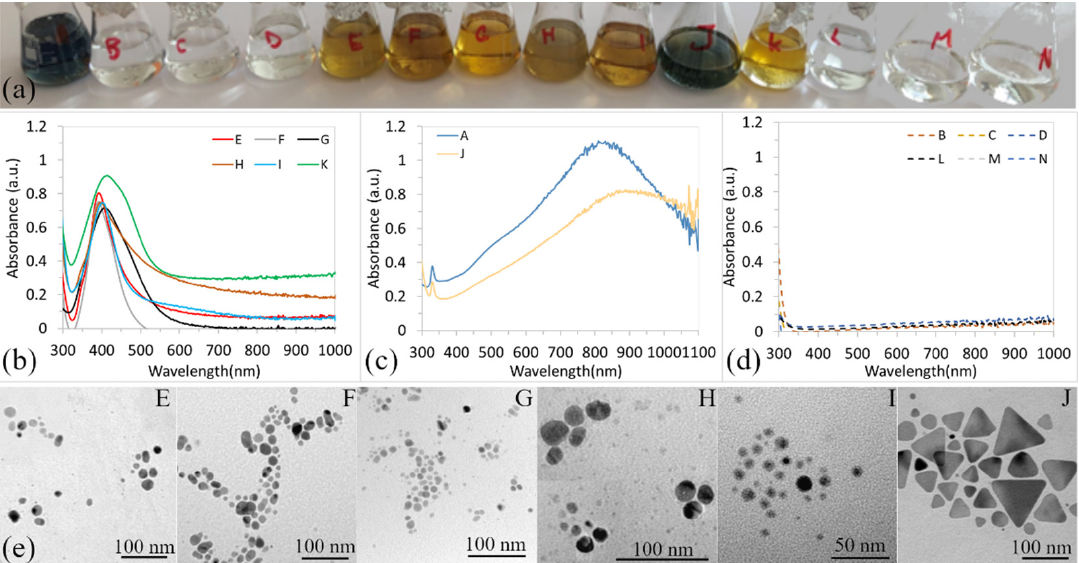
Figure 1. The AgNPs colloids of different colors ( a ); UV-vis of the first group of solution (yellow— E, F, G, H, I, K) ( b ); the second group (blue—A, J) ( c ); the third group—solutions without the nanoparticles ( d ); and the TEM images of AgNPs of colloidal solutions E, F, G, H, I and J (from left to right ) ( e ).